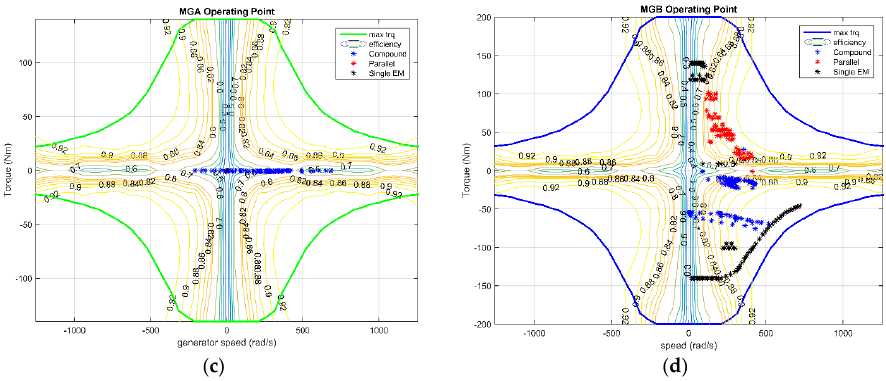
Figure 12. ( a ) Battery SOC trajectory and mode selection over the NEDC drive cycle; ( b ) engine optimal operation points over the NEDC drive cycle; ( c ) EMA operating points over the NEDC drive cycle; ( d ) EMB operating points over the NEDC drive cycle.